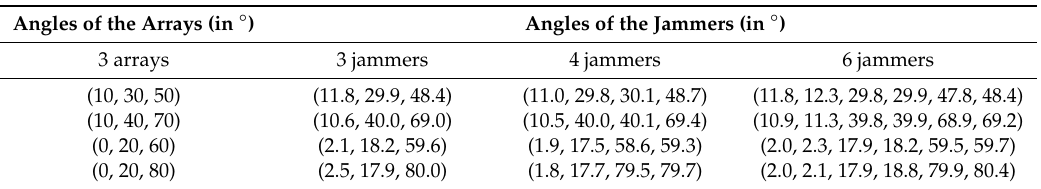
Table 2. Optimized angles of the jammers for di ff erent numbers of jammers with respect to the three-array networks with di ff erent angles in a single-target scene. Angles of the Arrays (in ◦ ) Angles of the Jammers (in ◦ ) 3 arrays 3